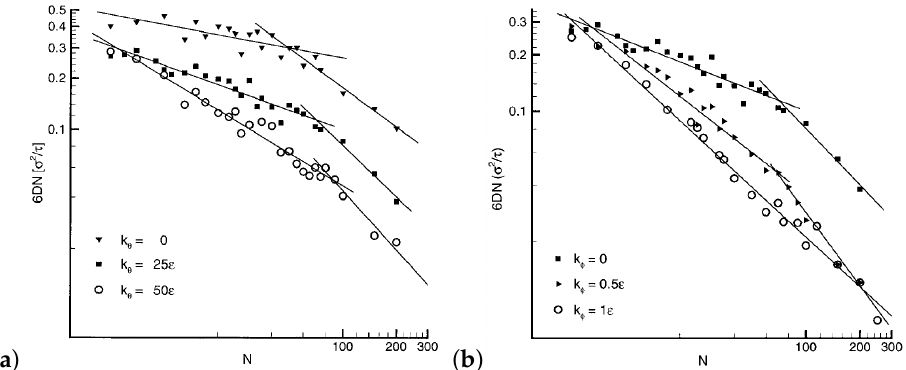
Figure 7. ( a ) The dependence of 6 DN on N for different bending rigidities in the absence of torsion stiffness, k φ = 0 (cid:101) . ( b ) The dependence of 6 DN on N for different torsion rigidities, at a constant bending strength k θ = 25 (cid:101) . Reprinted from [111] with permission from